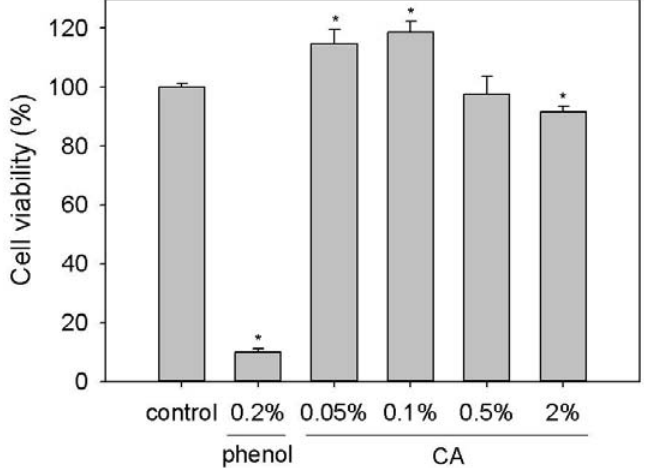
Figure 5. Cell viability of L-929 cells treated with various concentrations of Chitosonic ® Acid. Each value is expressed as the mean ± S.E. ( n = 3). * P < 0.05 compared with the control. CA: Chitosonic ®